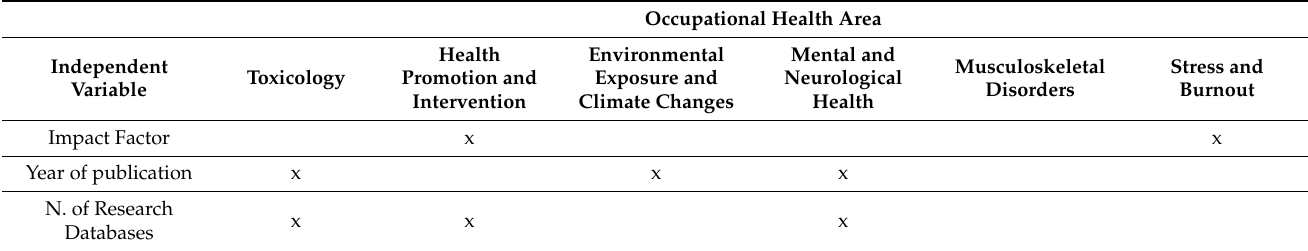
Table 5. Independent variables present in the multivariate analysis for each occupational health